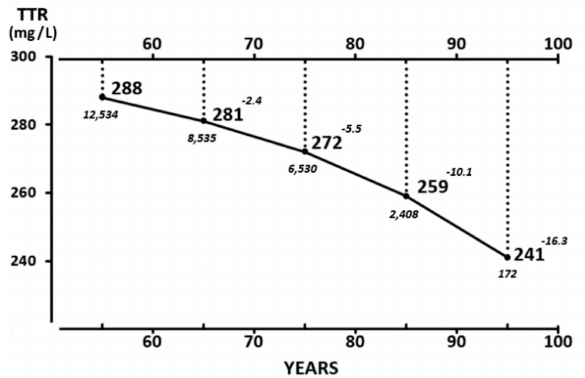
Figure 4. Mean TTR concentrations measured in healthy elderly subjects aged 65 to 100 years. TTR values are measured in 17,645 healthy U.S. elderly citizens (5796 men and 11,849 women) stratified into four groups (61–70, 71–80, 81–90, and 91–100 years of age) [79]. Mean values recorded in both sexes are combined owing to the lack of sexual di ff erence in TTR after 65 years and are expressed in bold characters. The number of participants and increasing deviation from plateau levels in each decennial category are shown in italics. TTR values recorded in both sexes during the last decades are well above 200 mg / L, which is regarded as the lower limit of normalcy, implying that these healthy centenarians, despite their on-going sarcopenia, do not face a life-threatening